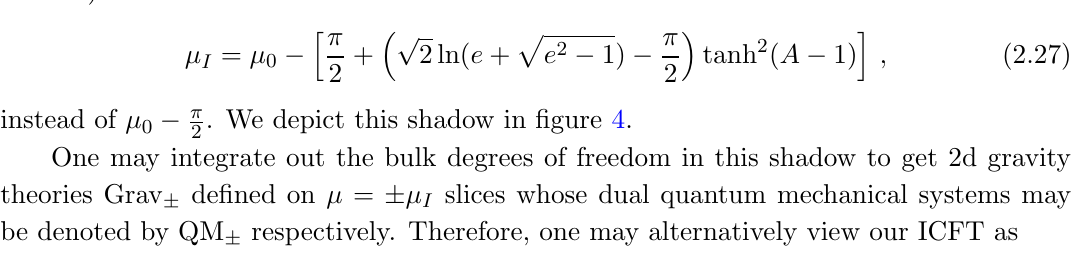
Figure 4 . We draw the shadow region speci(cid:12)ed by (cid:22) = constant slices ranged over (cid:22) One may integrate out the bulk degrees of freedom in this shadow region and view the resulting 2d gravity theories as living on the two slices at (cid:22) = as an extra bulk space created and a(cid:11)ected by the interfaces, which shall be dubbed as the shadow of the interfaces. However, this shadow region is not sharply de(cid:12)ned as we shall discuss further below. For our later purpose, we shall choose (cid:22) shadow) as